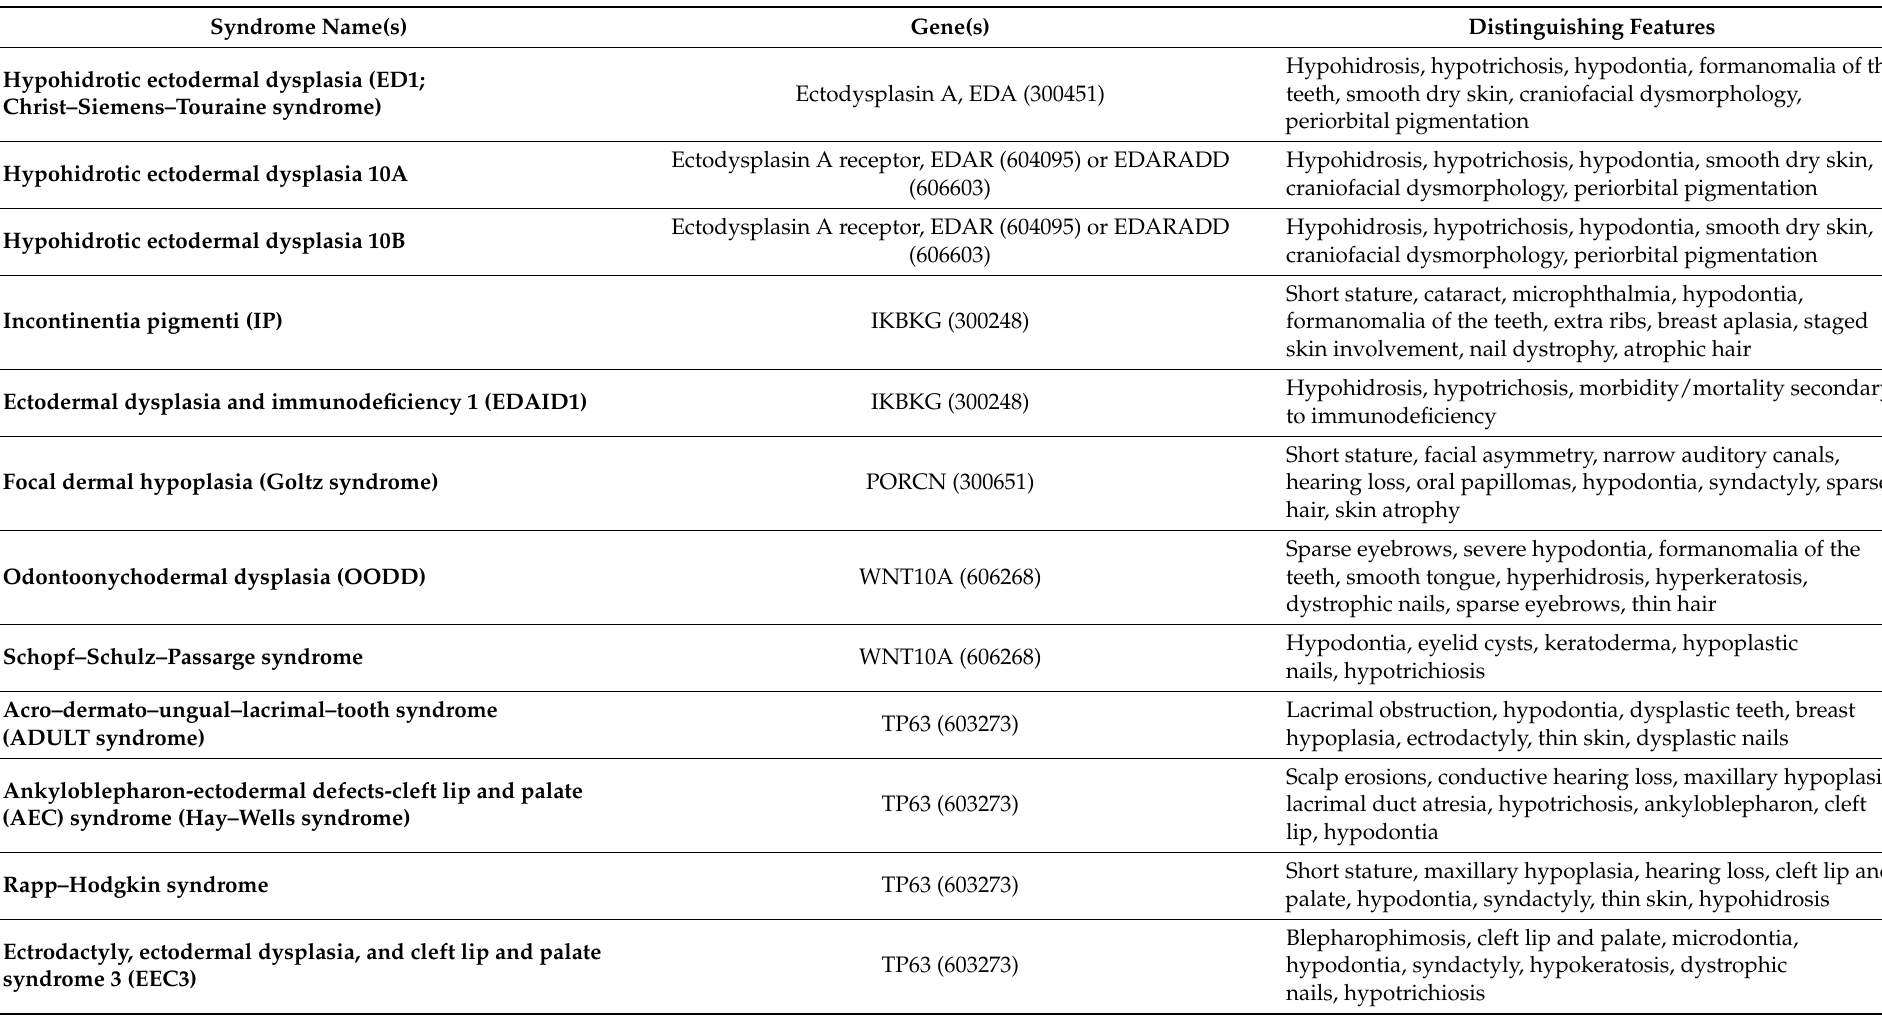
Table 1. Ectodermal dysplasia: Classification and organization by phenotype, genotype, and molecular signaling pathway (adapted from Wright et al.